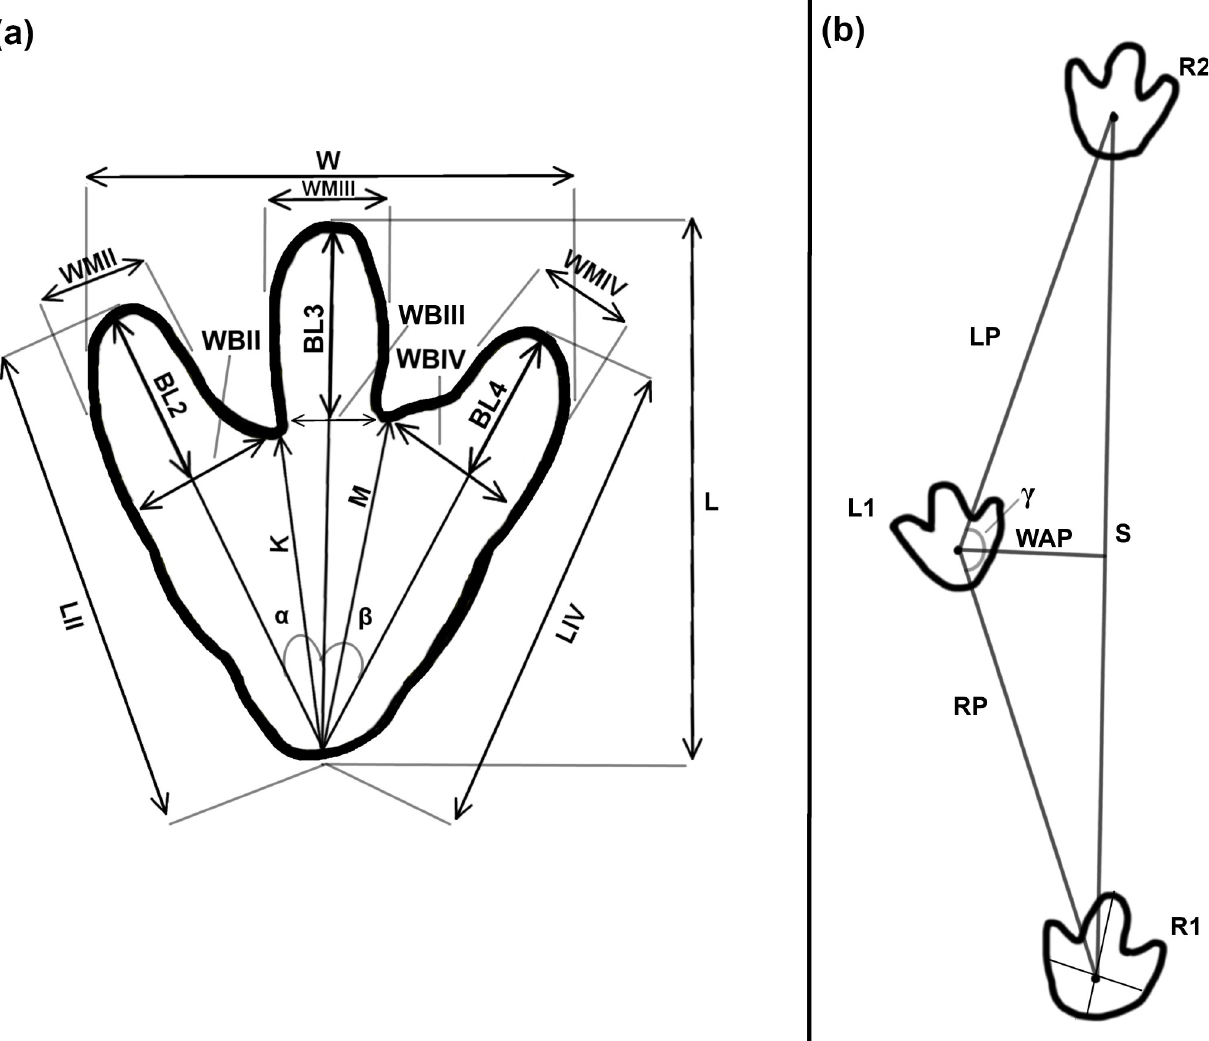
Fig 2. Track measurements for tridactyl tracks and trackways. (a) The measurements taken for each tridactyl track were derived from [37, 38, 42]. The abbreviations on the figure are as follows: total track length (L), total track width (W), total digital length (LII and LIV), basal digital length (BL), basal digital width (WB), middle digital width (WM), the heel-interdigital (hypex) distances (K and M), and the interdigital angles between digits II-III and digits III-IV ( α , β ). (b) This simplified bipedal tridactyl trackway shows how left and right pace (LP, RP), stride (S), width of angulation pattern (WAP), and the pace angulation ( γ ) are measured. Additionally, the lines used to define the ‘center of the track’ for trackway measurements are illustrated on track R1. Trackway measurements. We described bipedal trackways using pace (P), stride (S), width of angulation pattern (WAP), angle of rotation ( α ), and pace angulation ( γ ). Fig 2B shows an idealized approach to taking bipedal trackway measurements [44, 47, 48]. The pace of a bipedal trackway is the distance between consecutive, alternating footprints (i.e. right-left or left-right) [49]. Stride length is defined as the distance between corresponding points in suc- cessive prints from the same foot (i.e. the distance between one right pes impression and the next) [37, 38]. [38] suggested that the best reference point for bipedal trackway measurements is the “tip of the principal digit” as it is often a well-defined feature. Later workers have broadly adopted this practice using the tip of digit III as the point of reference [44, 50]. This approach,